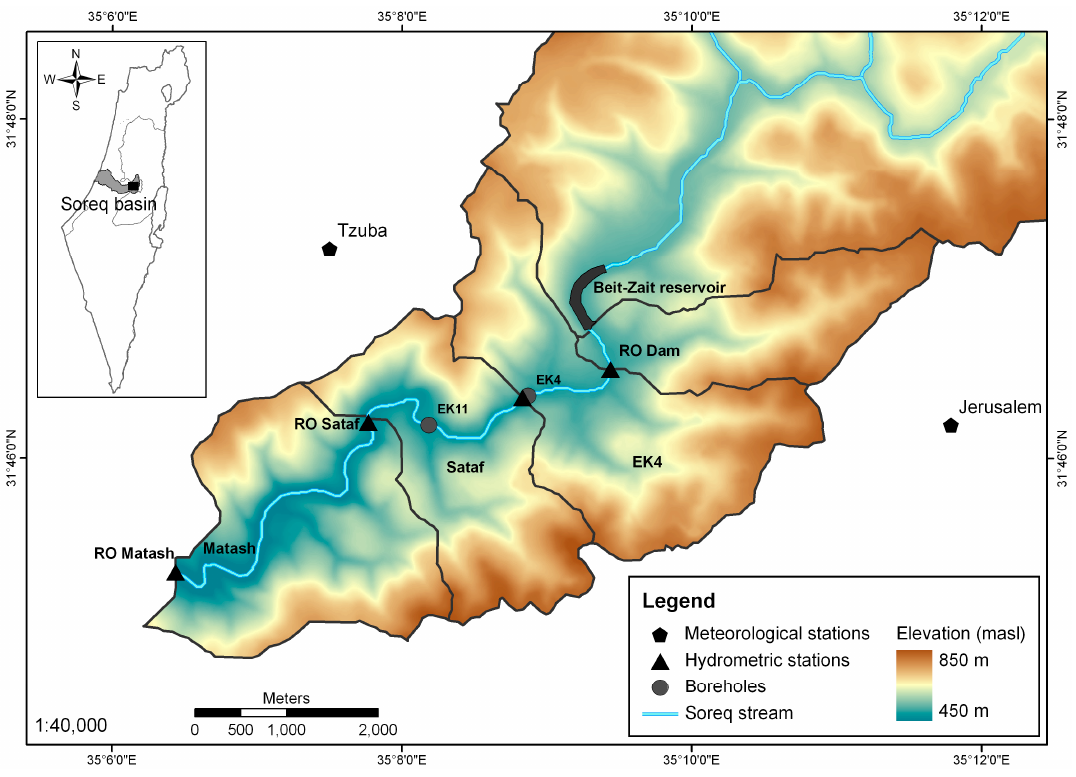
Figure 1. Soreq creek sub-basins and monitoring network.